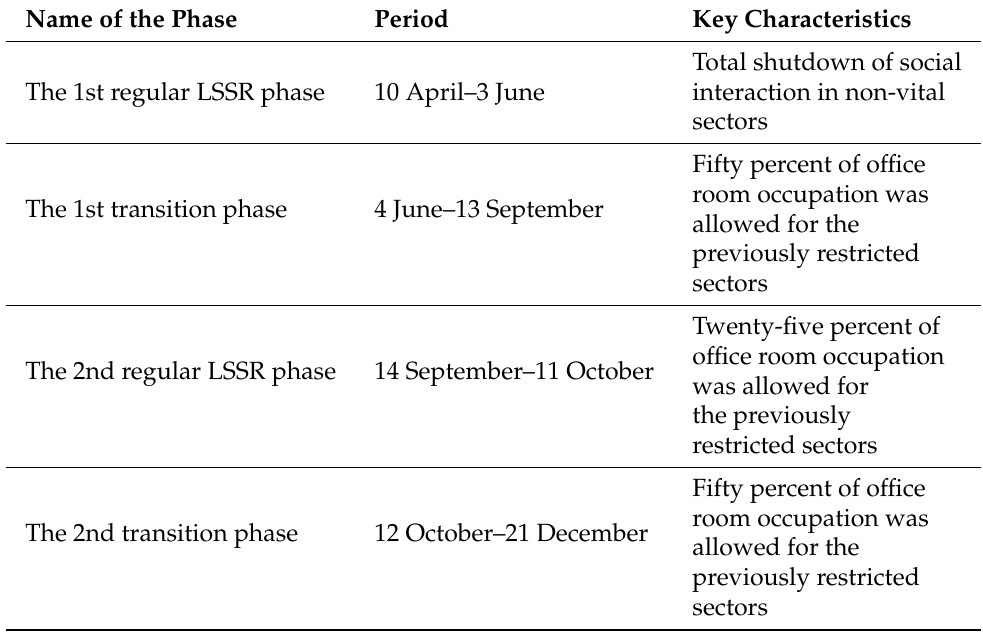
Table 1. LSSR Phases in Jakarta from April 2020 to December